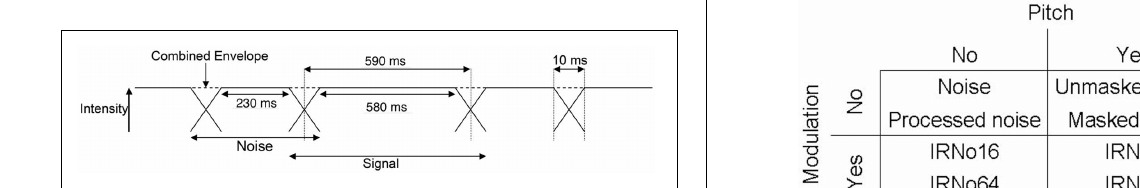
FIGURE 3 | Schematic representation of the subset of stimuli that contribute to the 2 × 2 factorial design. Each cell in the matrix contains two levels of salience except for the “no pitch, no modulation”